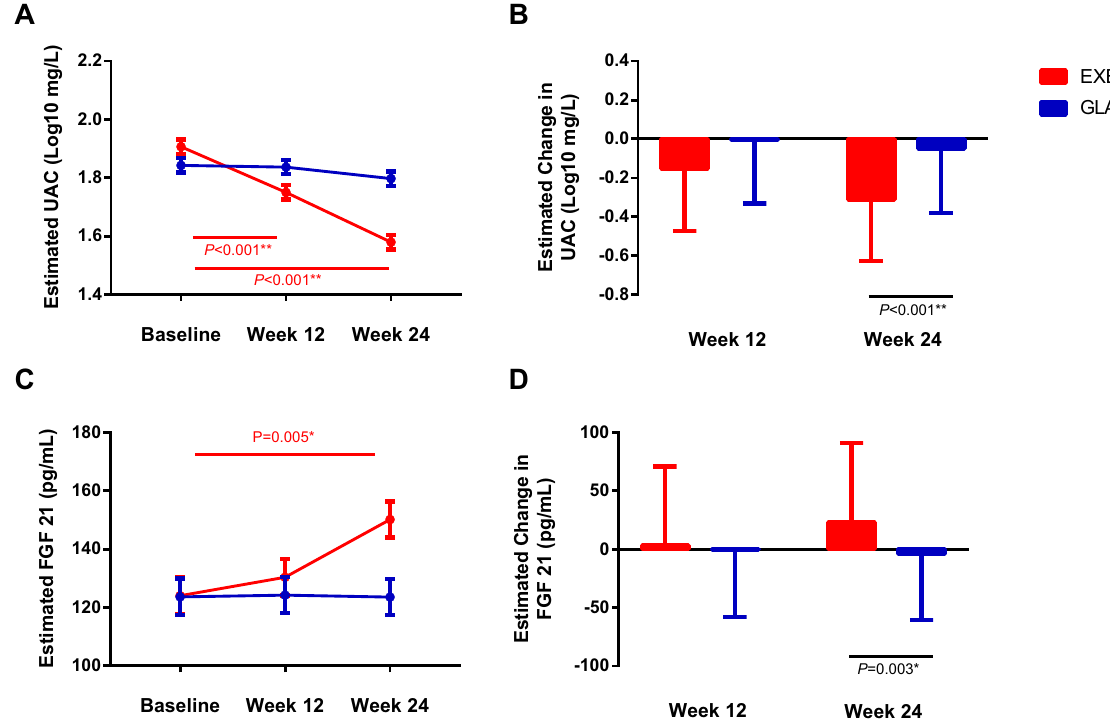
Figure 2. Comparison of changes in UAC and FGF 21 within and between the groups. The linear mixed-effects model was used to compare within-group and intergroup changes of UAC ( A , B ) and FGF 21 ( C , D ) with gender as covariant. Data are presented as means ± SD., * P < 0.01, ** P < ment, 19 patients (26.39%) had mild gastrointestinal adverse reactions. One patient with moderate adverse reac- tions was relieved spontaneously with the treatment cycle’s extension, without other adverse severe reactions. Primary end point. We conducted analyses to identify differences within and between groups of UAC dur- ing the study periods. EXE intervention could significantly reduce the UAC at week 12 and week 24 endpoints ( P < 0.001, Fig. 2A), while Insulin glargine did not significantly influence the UAC. Linear mixed-effects models analysis revealed that subjects in the EXE group had significantly improved UAC than those in the GLAR group at week 24 ( P < 0.001, Fig. 2B). Other efficacy variables. The anthropometric parameters (weight, BMI, WHR, VFA) and glucose param- eters and biomarkers of lipid profile and inflammation biomarkers (CRP, TNF-α and Il-6) showed no significant differences between the two groups at baseline. The anthropometric parameters (weight, BMI, WHR, VFA, P < 0.001 for all parameters at week 12 and week 24), glucose parameters (FBG, HbA1c, insulin and HOMA- IR, P < 0.001 for all parameters at week 12 and week 24), lipid parameters (TG: P = 0.020 at week 24; HDL-c: P = 0.049 at week 24), and inflammation biomarkers (CRP: P < 0.001 at week 24; TNF-α: P < 0.001 at week 12 and week 24) were significantly improved at both week 12 or week 24 endpoints in EXE group (Table 2). Mean- while, the comparison between groups showed that changes of anthropometric parameters (Weight: P = 0.002 at week 24; BMI: P < 0.001 at week 24; WHR: P = 0.008 at week 24; VFA: P < 0.001 at week 12 and week 24), glucose parameters (FBG: P < 0.001 at week 12 and P = 0.001 at week 24; HbA1c: P < 0.001 at week 12; C-peptide: P < 0.001 at week 12 and week 24; HOMA-IR: P = 0.004 at week 12 and P = 0.040 at week 24), lipid parameters (TG: P = 0.002 at week 12 and P = 0.012 at week 24; HDL-c: P = 0.001 at week 12 and P = 0.028 at week 24), and biomarkers of inflammation profile (CRP: P = 0.002 at week 12 and P < 0.001 at week 24; IL-6: P = 0.020 at week 24; TNF-α: P < 0.001 at week 12 and week 24) of patients in the EXE group were significantly different from those in another group at week 12 or week 24 (Table 2). Correlations between FGF 21 and other efficacy variables. To explore the mechanism of the reno- protective effect of EXE, we measured the level of serum FGF21. EXE significantly increased FGF 21 at week 24 ( P = 0.005, Fig. 2C). Between-group comparison uncovered that EXE group subjects had significantly improved FGF 21 level than those in the GLAR group at week 24 using linear mixed-effects models analysis ( P = 0.003, Fig. 2D). We then explored correlation-based network analysis among UAC, anthropometric parameters, glucose and lipid metabolism parameters, inflammation parameters, and FGF 21. The overall results demonstrated more associations between FGF 21 and other metabolic parameters in the EXE group when compared with the GLAR